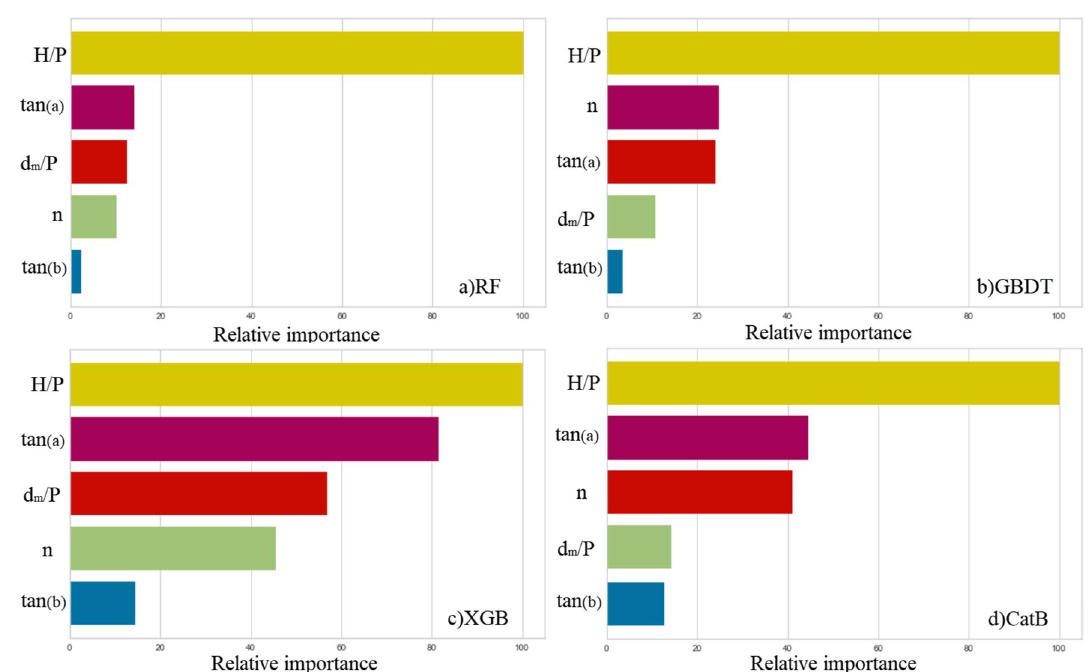
Fig. 9 Feature relative importance for estimation of Q